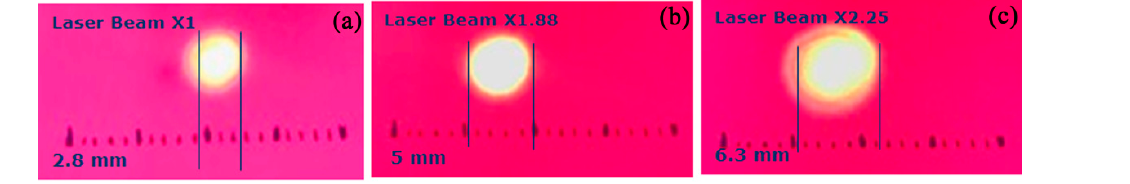
Figure 3. Beam profile of the infrared femtosecond laser beam. ( a ) Before beam expander; ( b ) after the ×1.88 beam expander; ( c ) after the ×2.25 beam expander.